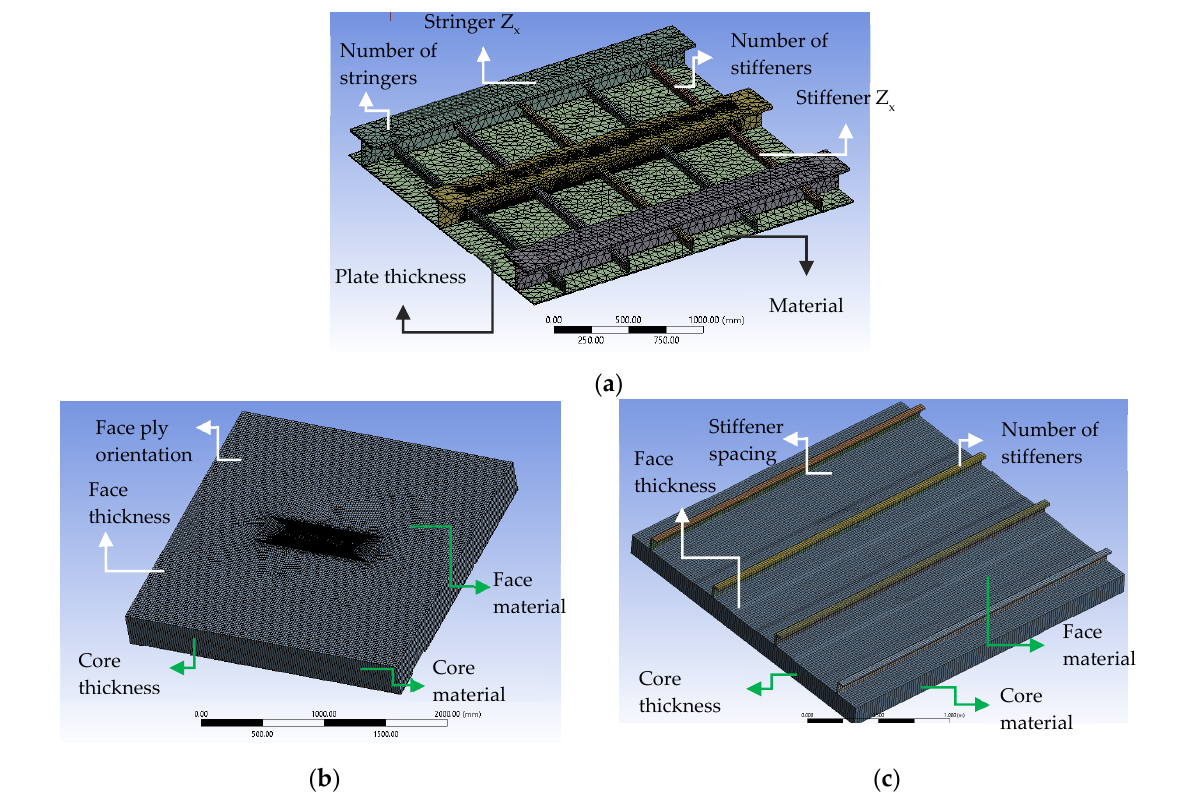
Figure 3. Parametrization of ( a ) metal grillage, ( b ) sandwich panel and ( c ) stiffened sandwich panel. For steel grillages, ice-class rules for class 1B following FSICR (2021) were used to deduce initial scantlings and define the upper parametric limit. The lower limit was taken as per inland navigation rules [30]. For aluminum alloy, we used similar scantlings since there are no rules for this material. The girders have a T cross-section while the stiffeners have an L cross-section. The choice of parameters for the FRP composite was deduced using the constant stiffness design method [31]. The structural design calculations for a panel of dimensions 2.4 m × 2.4 m with a pressure patch representing ice pressure given by FSICR (2021) in the middle were performed. We minimized the structure for mass with constraints for stiffness w / b ≤ 0.02 and strength σ f , max = E f /64 [32]. The resulting face and core thicknesses were used as a reference to decide the parameters. For the stiffened sandwich, a similar approach was used where the face sheet and core thicknesses are deduced. The stiffener section moduli were chosen to correspond to the metal grillage to create a basis for comparison.